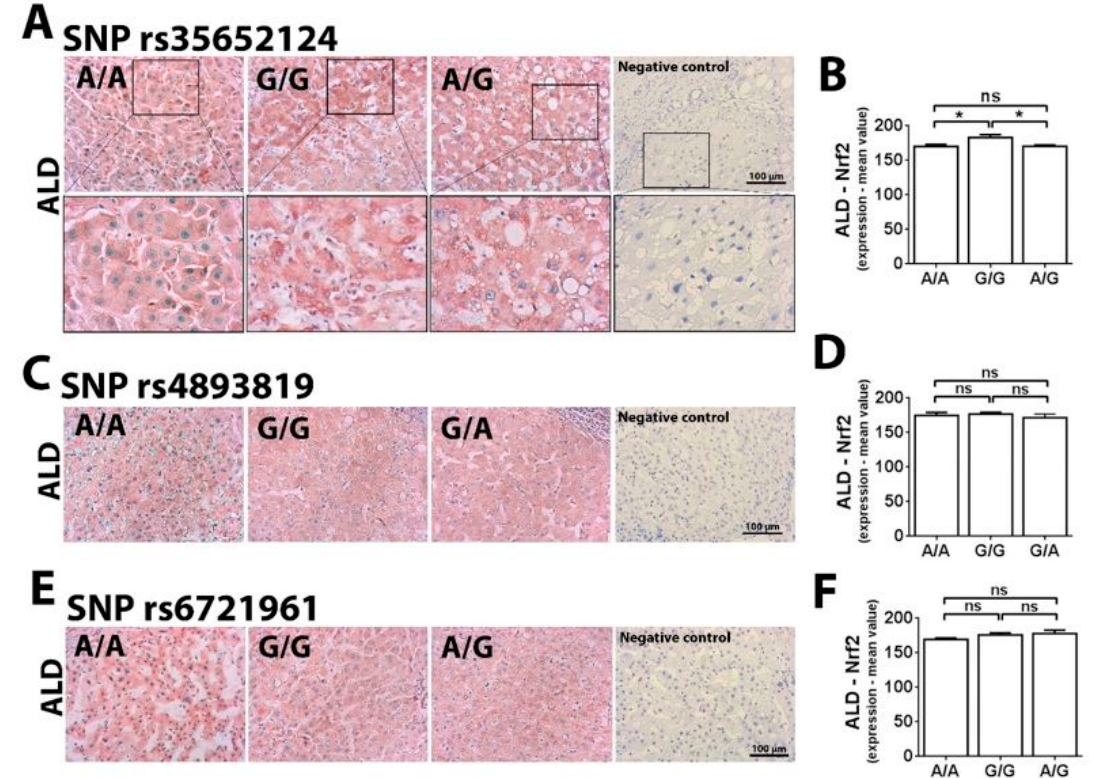
Figure 2. Nrf2 expression in the different polymorphisms of NFE2L2 gene in patients with ALD-associated cirrhosis. ( A ) Immunohistochemistry for Nrf2 in in the SNP rs35652124 genotypes. ( B ) Quantification of Nrf2 expression (mean value) in the di ff erent genotypes of SNP rs35652124. ( C ) Immunohistochemistry for Nrf2 in the SNP rs4893819 genotypes. ( D ) Quantification of Nrf2 expression (mean value) in the different genotypes of SNP rs4893819. ( E ) Immunohistochemistry for Nrf2 in the SNP rs6721961 genotypes. ( F ) Quantification of Nrf2 expression (mean value) in di ff erent genotypes of SNP rs6721961 (n = 15 patients with ALD-associated cirrhosis; and n = 5 patients in each genotype. * p < 0.05. Values are expressed as mean ±